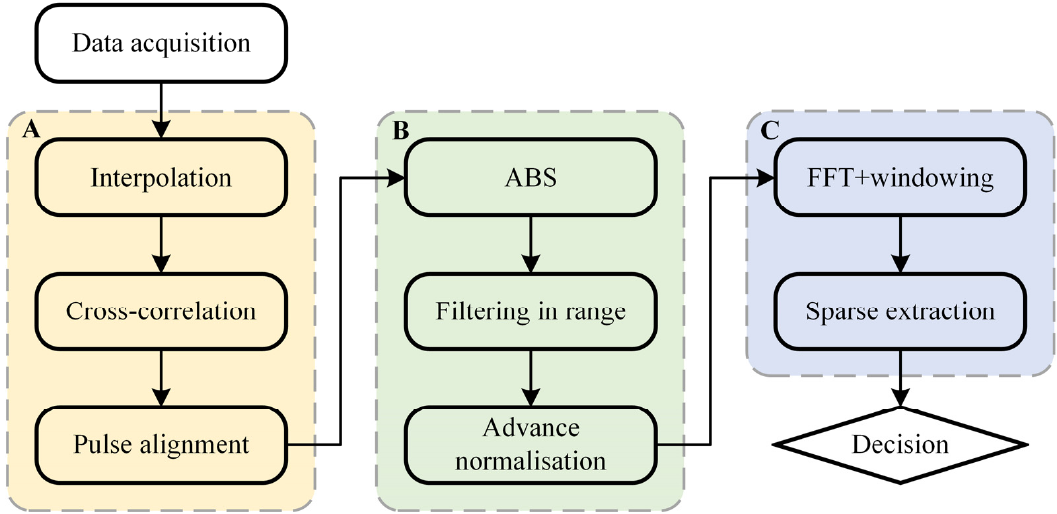
Figure 3. Flowchart of the proposed method.